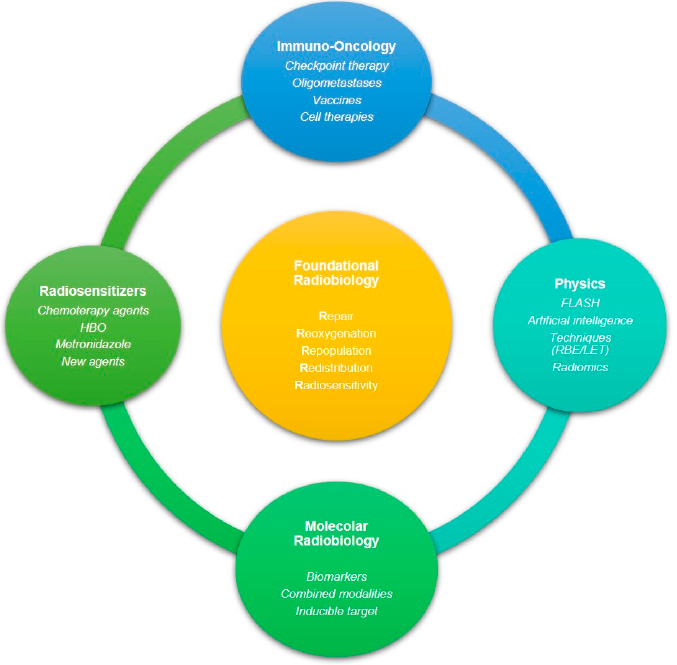
Figure 2. The multifaceted spectrum of radiation biology research, mechanisms, and clinical applications. In the center, the 5Rs explain the biological basis of radiobiology.